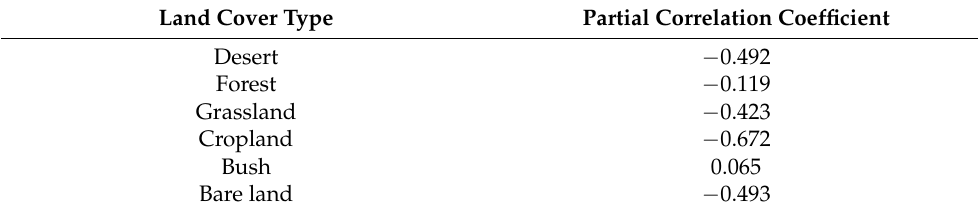
Figure 13. Relationship between different land cover types and temperature. Table 7. Partial correlation analysis of air temperature and